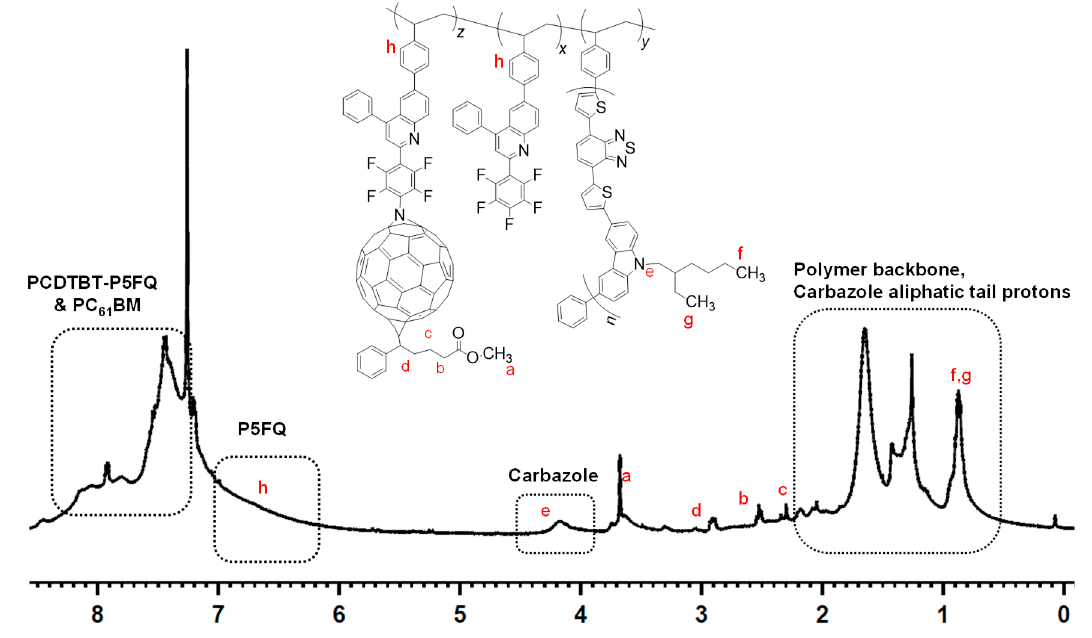
Figure 10. 1 H NMR spectrum of P3,6C(EH)DTBT-(P5FQ-(P5FQ-N-PC 61 BM)) in CDCl 3 .